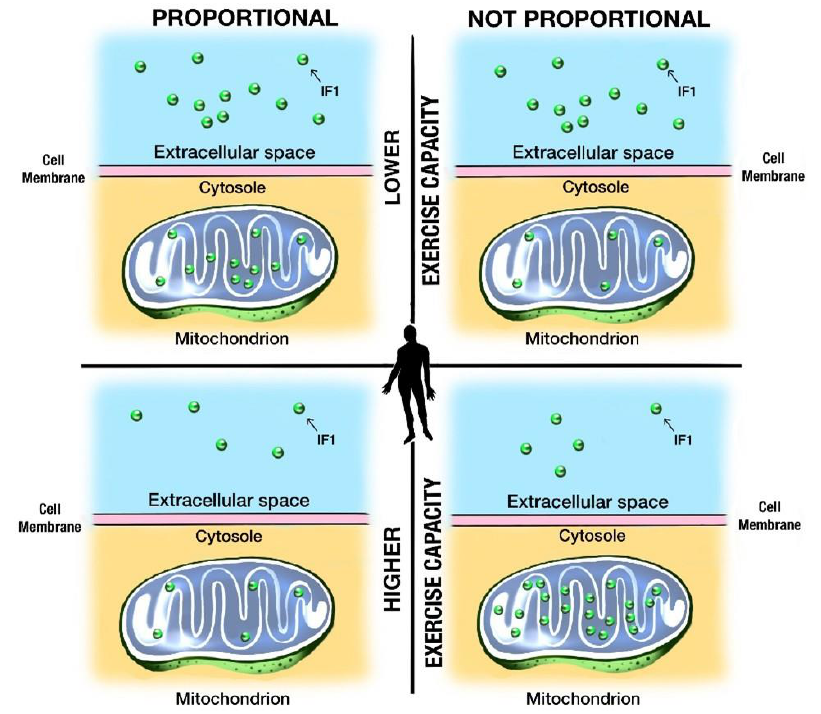
Figure 1. The potential effect of physical activity on mitochondrial membrane integrity and IF1- permeability in two scenarios. Firstly, IF1 in the blood is proportional (left part of the figure) to the IF1 in mitochondria. Secondly, IF1 in the blood is not proportional (right part of the figure) to the IF1 in mitochondria. In the first scenario, non-exercising people with lower exercise capacity are shown in the upper left corner. They need more IF1 to reduce the risk of ATP hydrolysis (and depletion) in mitochondria during occasional physical effort accompanied by hypoxia and acidosis. More IF1 in mitochondria, according to the proportional concept, translates to more IF1 in the blood. In the same scenario, physically active people with better exercise capacity are presented in the bottom left corner. Such individuals do not need a lot of IF1 in mitochondria due to certain other metabolic adaptations protecting against frequent hypoxia/academia bouts during repeated training. Therefore, in the proportional concept, IF1 is either lower or higher in mitochondria and the circulating blood. The second scenario might be explained by not proportional IF1 content in the blood and mitochondria. In this case, lower IF1 in the circulating blood would be associated with a higher mitochondrial IF1 content and vice versa. Non-exercising people with lower exercise capacity (upper right corner) have more IF1 in the blood, as it is not highly demanded in mitochondria, which are not under repeated hypoxia and acidosis. IF1 would be leaked or effluxed from mitochondria to the extracellular and intravascular spaces in such a case. In contrast, the mitochondria of regularly exercising people and those with a better exercise capacity (bottom right corner) need more IF1, so they develop mechanisms to protect IF1 inside and prevent ATP hydrolysis due to more frequent exercise-triggered hypoxia/acidosis. In our opinion, this scenario is more likely and favors the mitochondrial/cell integrity hypothesis. Regular physical activity promotes adaptations to exercise, such as mitochondrial biogenesis, integrity, and the ability of mitochondria to prevent oxidative